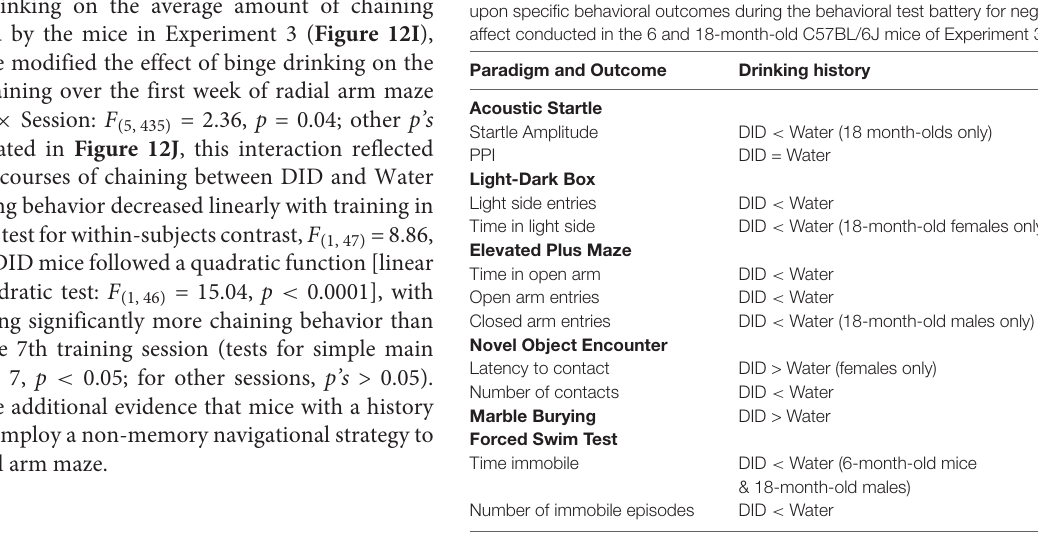
TABLE 3 | Summary of the effects of a 1-month binge drinking (DID) paradigm upon specific behavioral outcomes during the behavioral test battery for